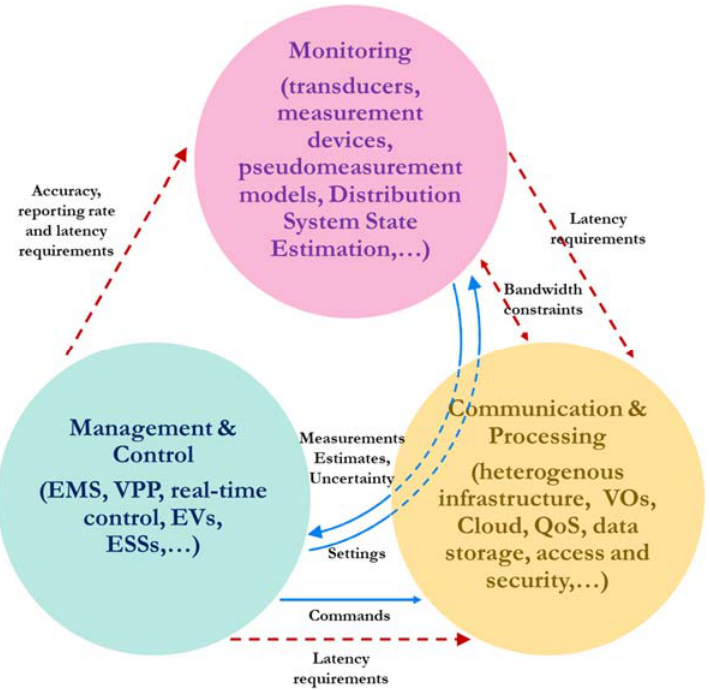
Figure 3. Multidisciplinary interactions in design, development and operation of SDN.